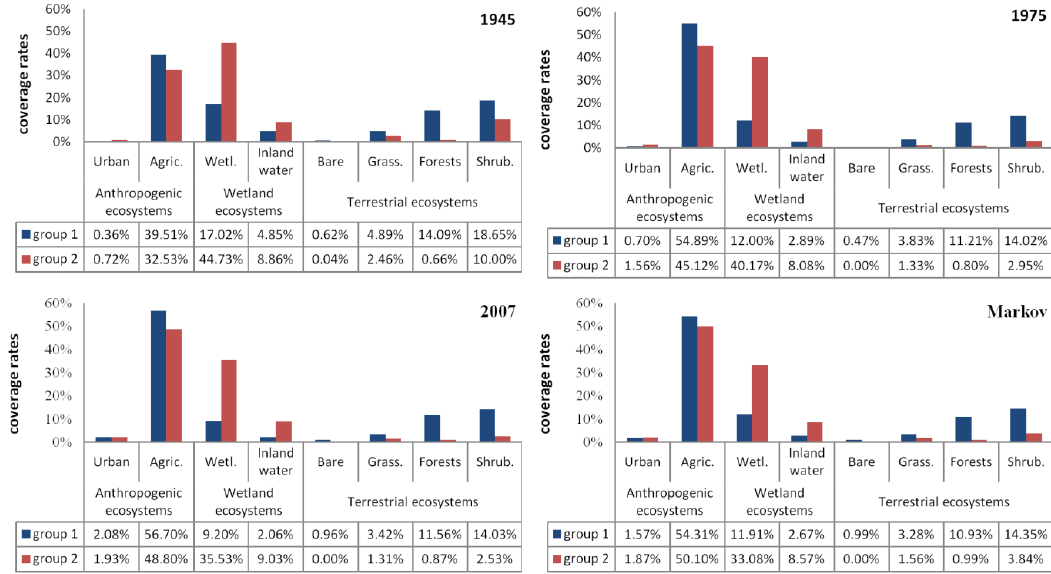
Figure 7. Averaged landscape composition of group 1 (blue) and group 2 (red) for the years 1945, 1975, and 2007, and the expected Markov equilibrium state. Agric.: agricultural land; Wetl.: wetlands, Grass.: grasslands; Shrub.: shrublands; Bare: bare land.